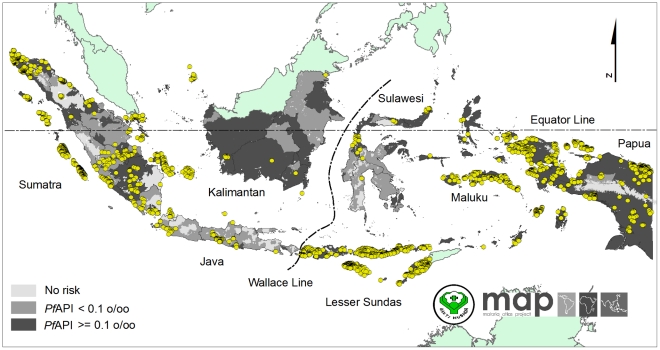
The spatial limits of Plasmodium falciparum defined by Annual Parasite Incidence and the temperature mask.Areas were defined as stable (dark grey areas, where PfAPI≥0.1 per 1,000 pa), unstable (medium grey areas, where PfAPI<0.1 per 1,000 pa), or no risk (light grey, where PfAPI = 0 per 1,000 pa). The 2,516 community surveys of P. falciparum prevalence conducted between 01 January 1985 and 31 May 2010 are plotted.